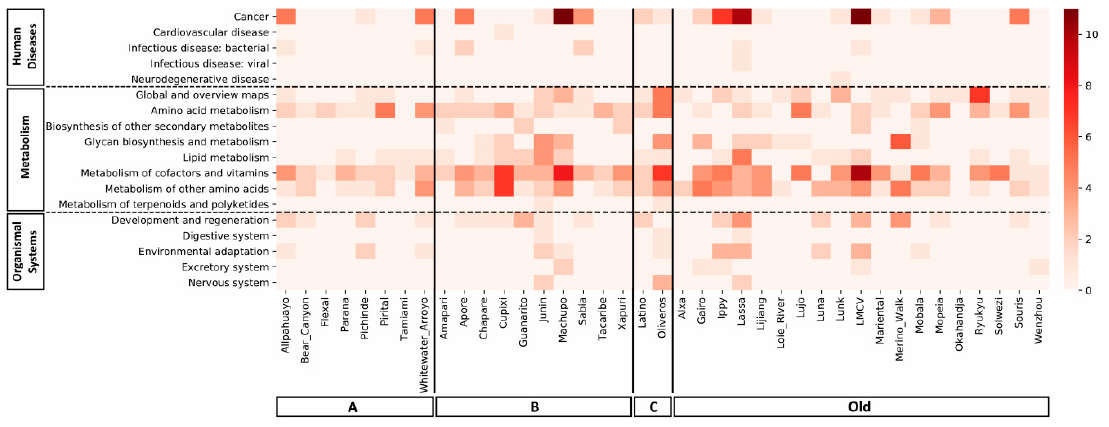
Figure 4. Heatmap of predicted miRNA–pathway subgroup interactions for each mammarenavirus. Scale demonstrates how many times a pathway that belonged to a KEGG pathway subgroup was targeted by a miRNA (if a miRNA targeted more than one pathway in the same subgroup it was counted as many times).